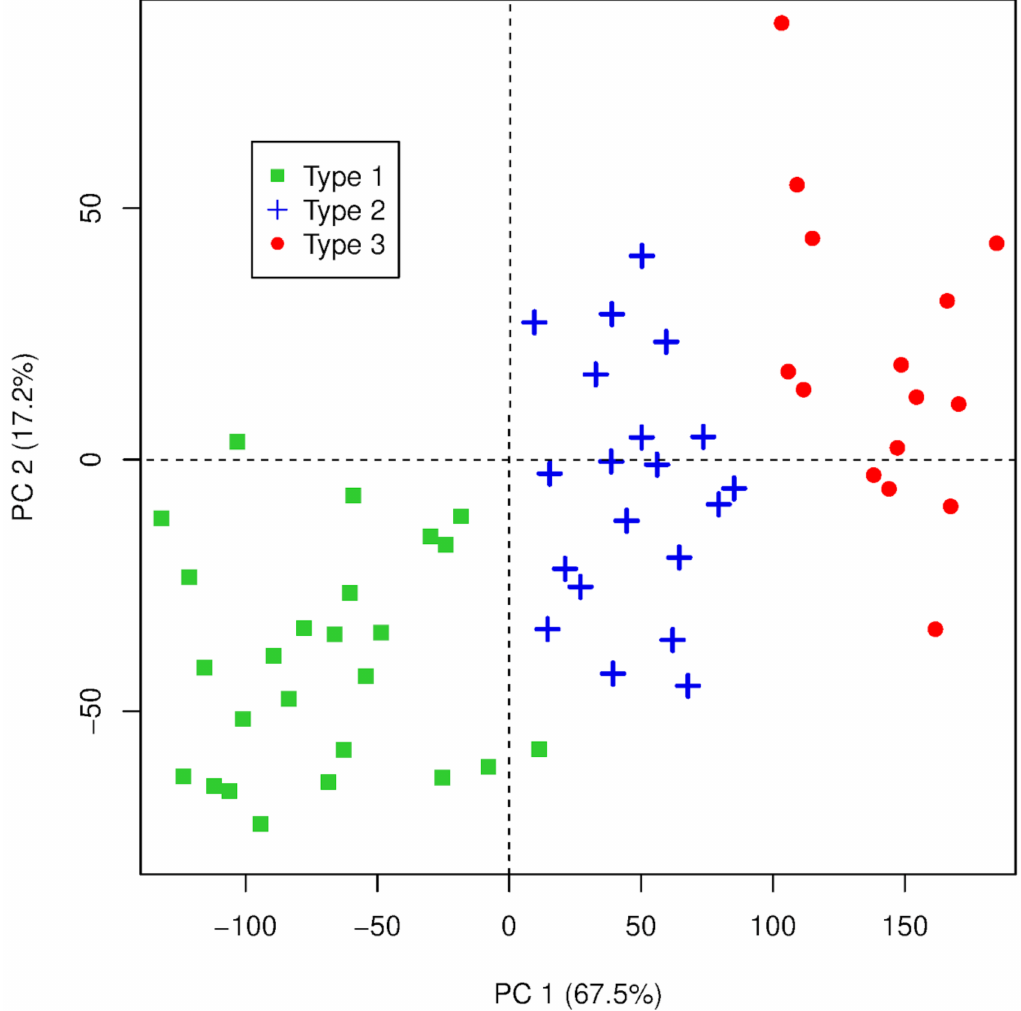
Figure 2. Two-dimensional representation on the PC1 and PC2